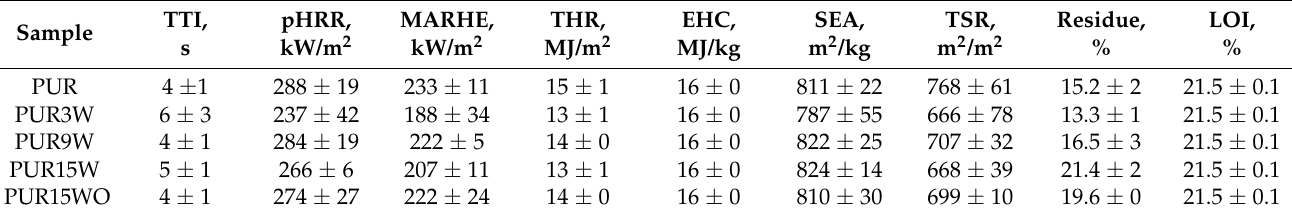
Figure 11. Representative heat release rate curves of PU foams modified with vermiculite. Table 6. Cone calorimeter test results of the tested foams.